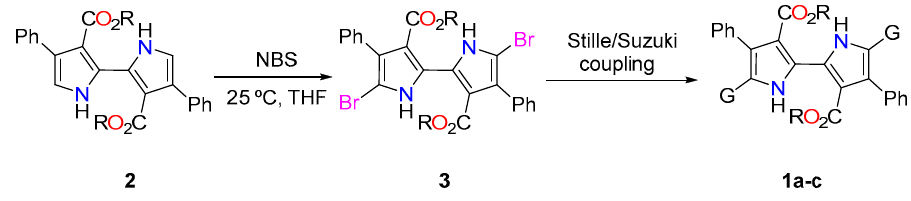
Figure 2. Synthesis of 2,2 (cid:48) -bipyrroles 1a–c (G = 2-pyrrolyl, 2-( N -methylpyrrolyl) and 2-thienyl, R = Et).